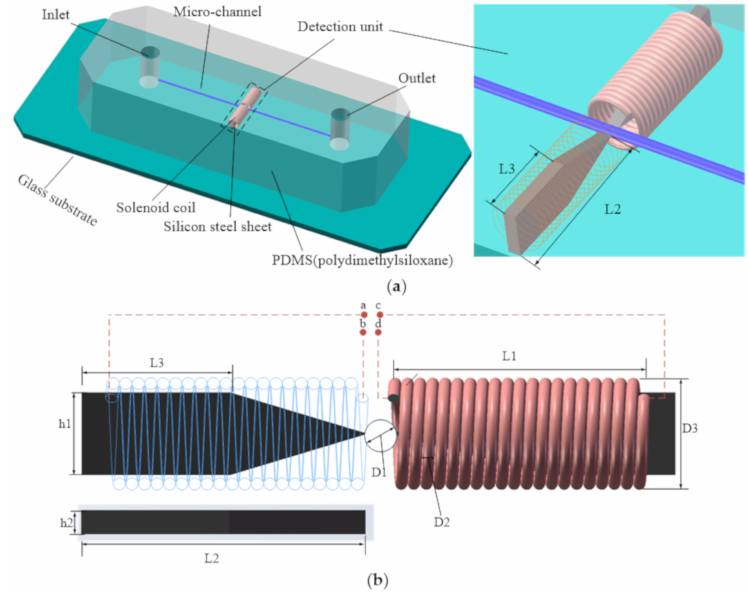
Figure 1. The design of the multifunction sensor: ( a ) the overall design of the chip, and ( b ) a sketch of the detection unit.